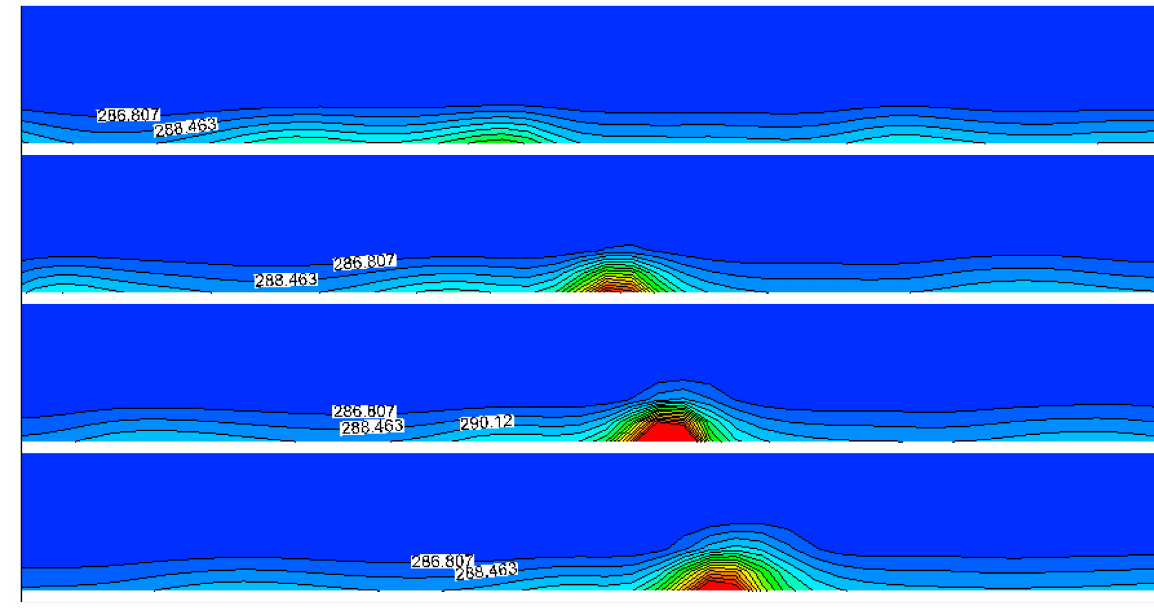
Figure 5. The isothermal line of a sliding bubble near the heating